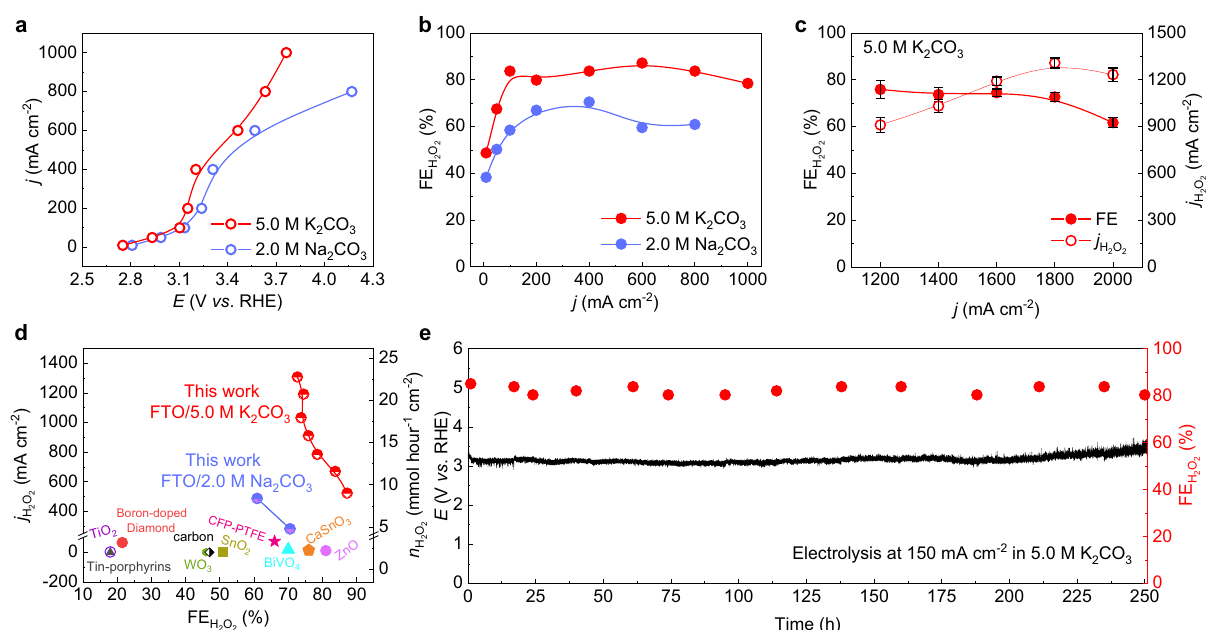
Fig. 3 Electrochemical 2e − -WOR performance using high concentration carbonate mediator. a I – V curves of FTO catalyst in 2.0 M Na 2 CO 3 and 5.0 M K 2 CO 3 . K 2 CO 3 was chosen due to its higher solubility than Na 2 CO 3 . The maximal current density in our standard three-electrode cell was cut at 1 A cm − 2 . b The corresponding H 2 O 2 FEs. The highest FE reached 87% in 5.0 M K 2 CO 3 with a current density of 600 mA cm − 2 under 3.46 V. c H 2 O 2 FEs and partial currents in 5.0 M K 2 CO 3 solution with current densities greater than 1 A cm − 2 . The error bars represent two independent tests. d Comparison of H 2 O 2 selectivity and activity between this work and previous reports 7,9,11 – 14,41 . e The stability test of FTO catalyst by maintaining a 150 mA cm − 2 WOR current in 5.0 M K 2 CO 3 solution. Its H 2 O 2 selectivity and potential remained stable for a 250-hour continuous